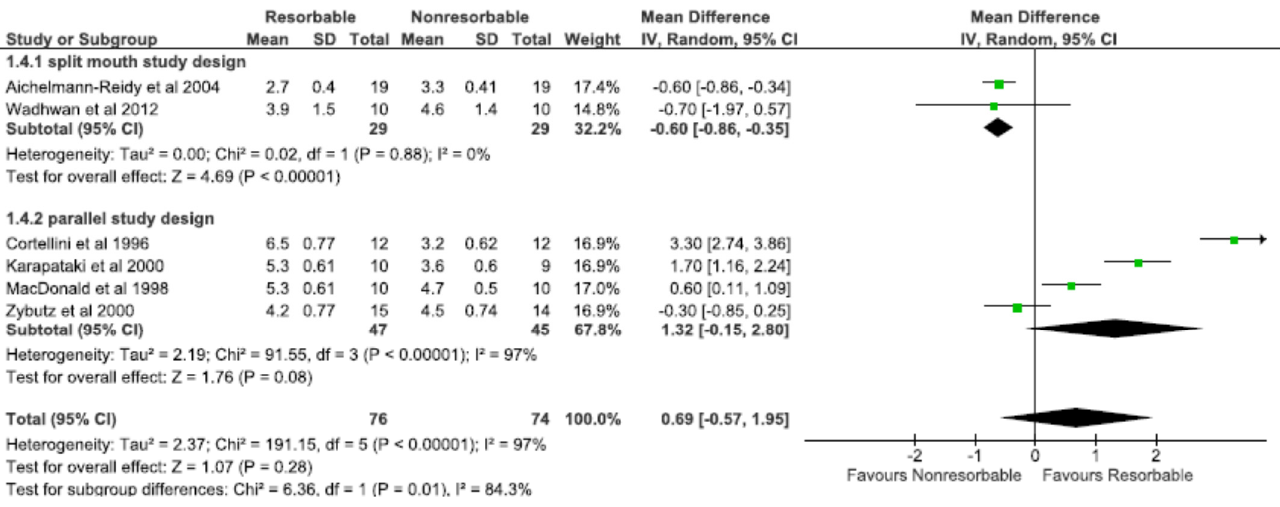
Figure 6. Meta-analysis of clinical attachment level (CAL) at all intervals (6–12 months).